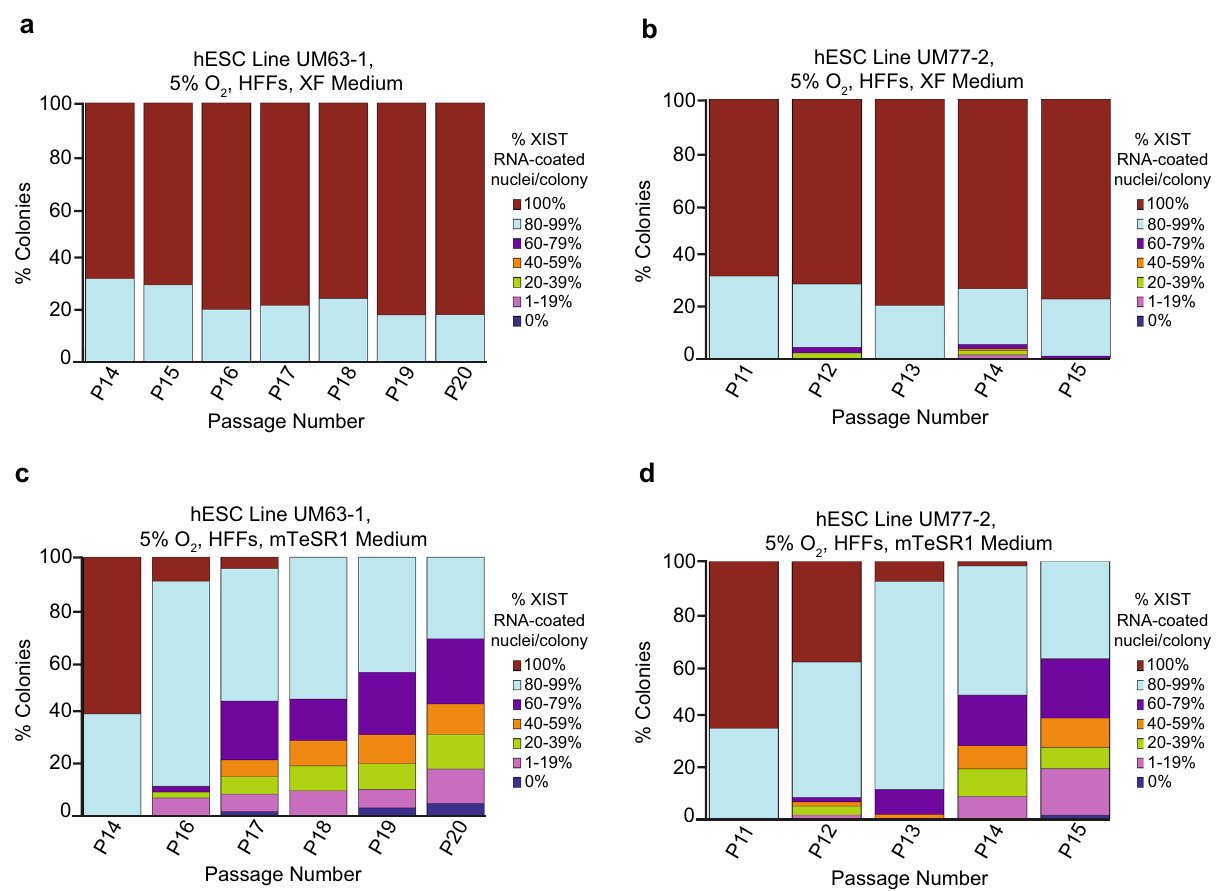
Fig. 4 Impact of culture medium on XIST RNA coating in female hESCs. a – d Percentage of nuclei with XIST RNA coats per colony in hESC lines UM63-1 ( a , c ) and UM77-2 ( b , d ) cultured in parallel in XF medium ( a , b ) and mTeSR1 medium ( c , d ) on HFFs. hESCs cultured with mTeSR1 medium displayed a signi fi cant decrease in nuclei with XIST RNA coating compared to hESCs cultured in XF medium during passaging (general linear model comparison; p < 0.001). All hESCs in this experiment were cultured in 5% O fi cation data for P13-14 in b are taken from Fig. 3b. At least 100 nuclei 2 on HFFs. The quanti were counted per colony for hESC RNA FISH quanti fi cation. The total number of colonies quanti fi ed at each passage range between 10 and 180 and are cataloged in source data. Source data are provided as a Source Data fi